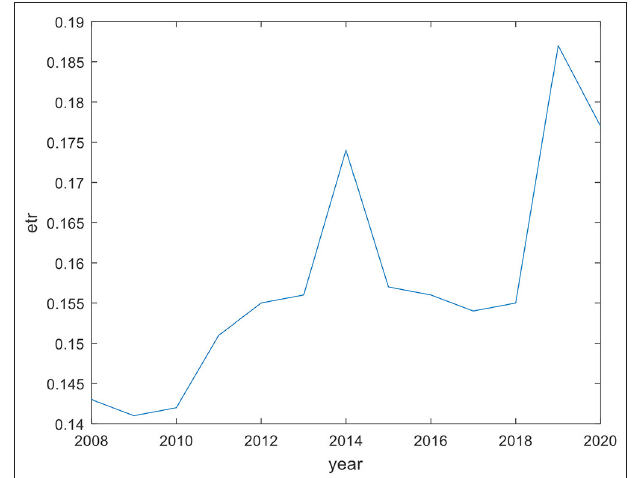
FIGURE 2 | Actual tax bearing rate of income tax (2008–2020).